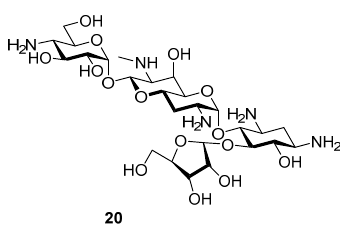
Figure 3. Structure of Apralog 20